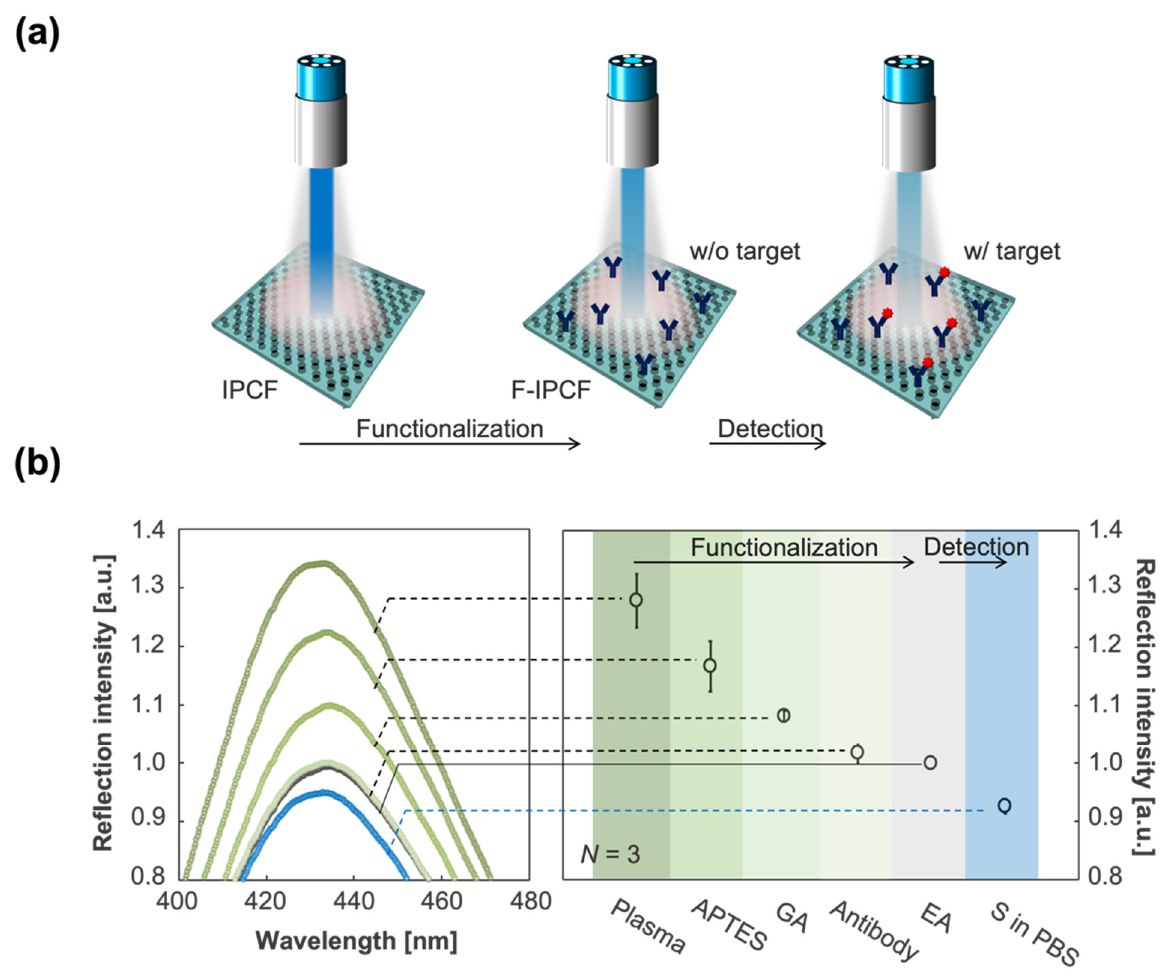
Figure 3. Functionalization of the IPCF for application to label-free optical sensor of SARS-CoV-2 spike proteins ( S ). ( a ) Schematics of the functionalization of the IPCF for label-free detection of spike proteins ( S ). ( b ) (Left) Magnified reflection spectra for the 2nd peak of IPCF during the modification processes: air-plasma treatment, APTES, GA, antibody and EA modifications, and after incubation in the spike-protein-containing (1 ng/mL) PBS sample solution. Each spectrum was normalized by that of F-IPCF. (Right) Plots of maximum reflection intensity, R , after each modification process ( N = 3).